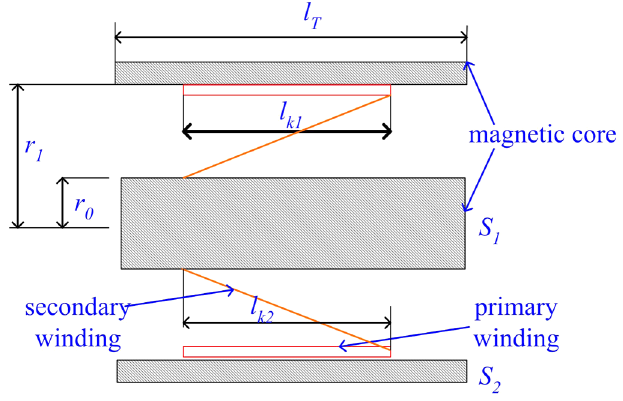
FIG. 2. Magnetic field distribution of the